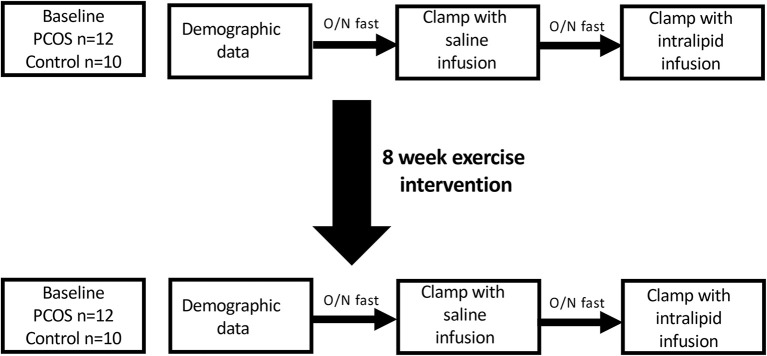
Overall study scheme.